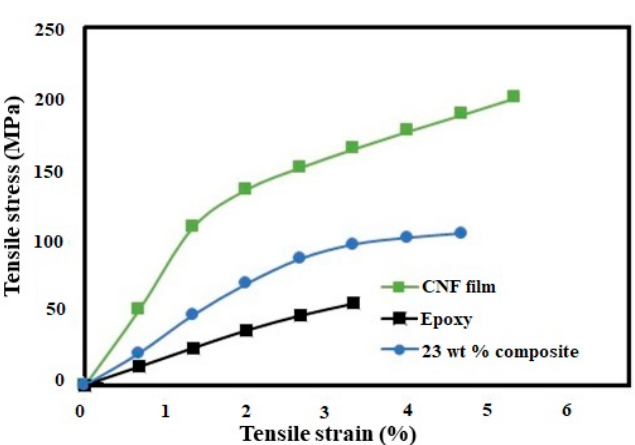
Figure 4. Representative stress-strain curves of the CNF film cured neat epoxy resin, and composite.